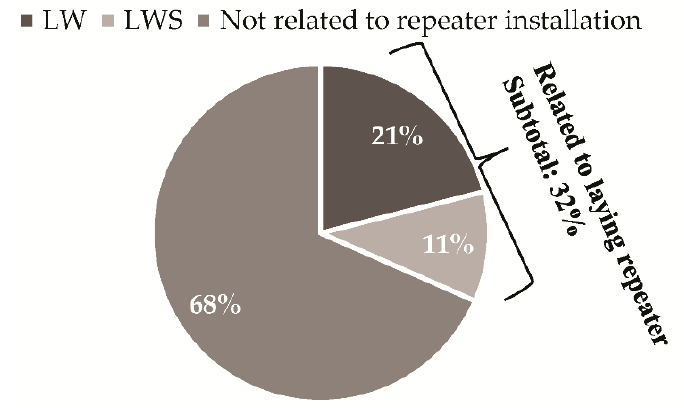
Figure 15. Proportion of cable fault triggered by laying repeater in 1999 to 2016.